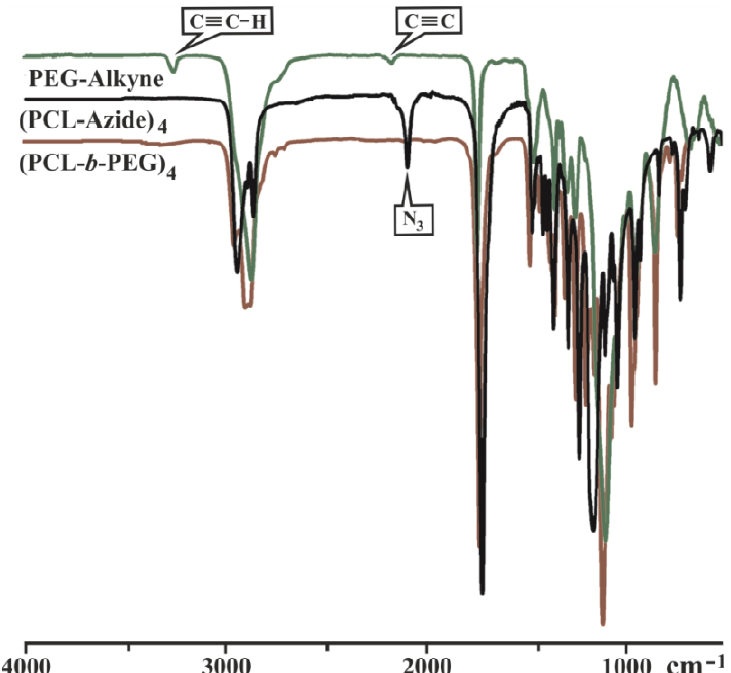
and the resulting (PCL- b -PEG) 4